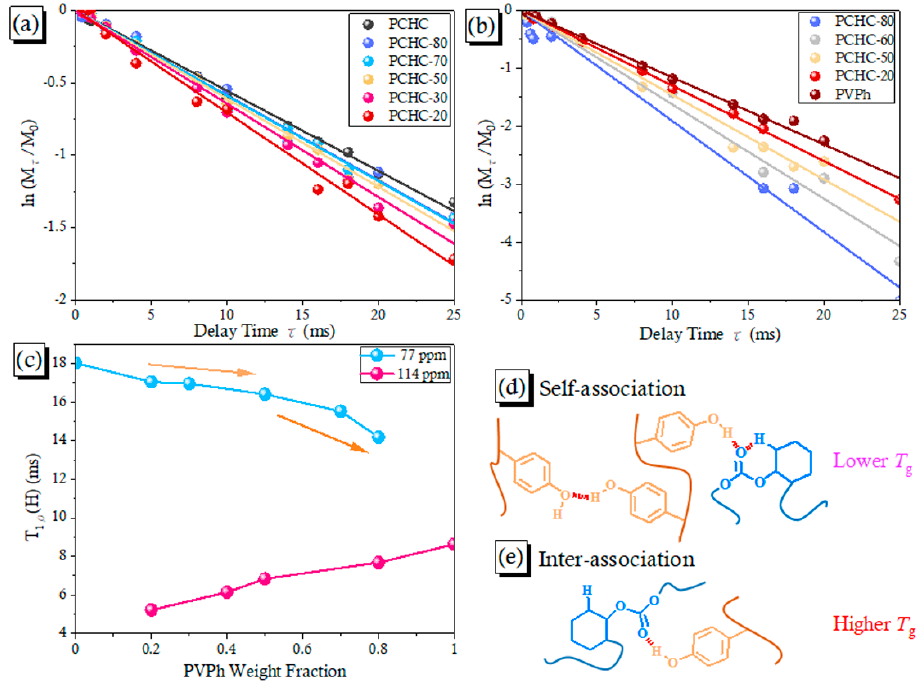
Figure 8. ( a , b ) Semi-logarithmic plots of the magnetization intensities of the signals at ( a ) 114 and ( b ) 77 ppm, plotted with respect to the delay time of various PVPh/PCHC binary blends; ( c ) Values of T 1 ρ (H) of various PVPh/PCHC binary blends; ( d , e ) Possible H-bonding through ( d ) self-association H-bonding of PVPh at lower concentrations of PVPh; and ( e ) intermolecular H-bonding of PVPh/PCHC binary blends at higher concentrations of PVPh.